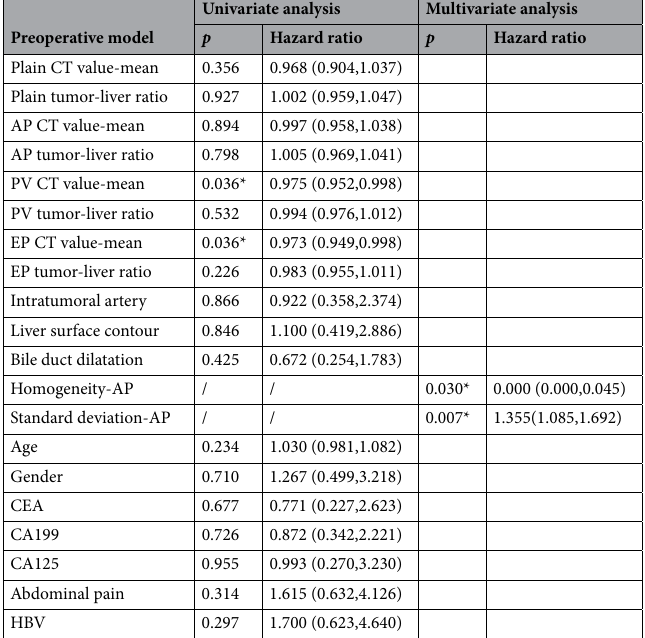
Table 2. Logistic regression analysis for predicting early recurrence of IMCC based on basic CT imaging features, radiomics features and clinical indicators (Preoperative model). PV portal venous phase, EP equilibrium phase. * p < 0.05, AP arterial phase.